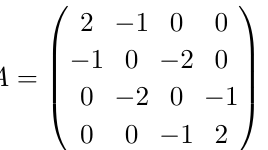
Figure 1 . Dynkin diagram of a Borcherds Lie superalgebra that is related to a quotient of the free Lie superalgebra of D = 4